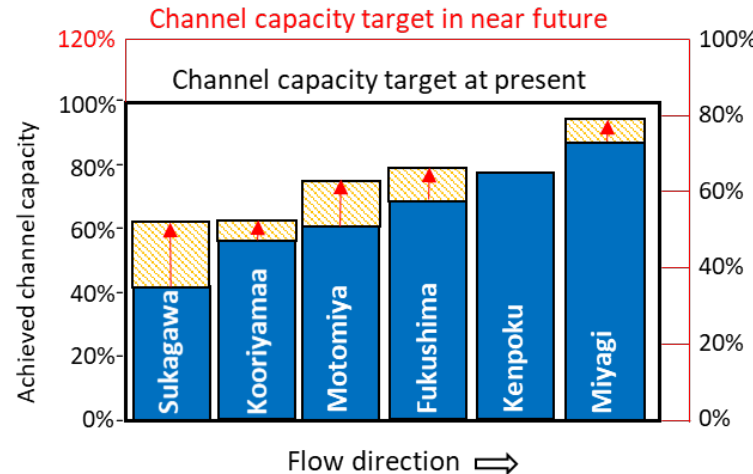
Figure 4. Expected achievement for first river improvement plan.